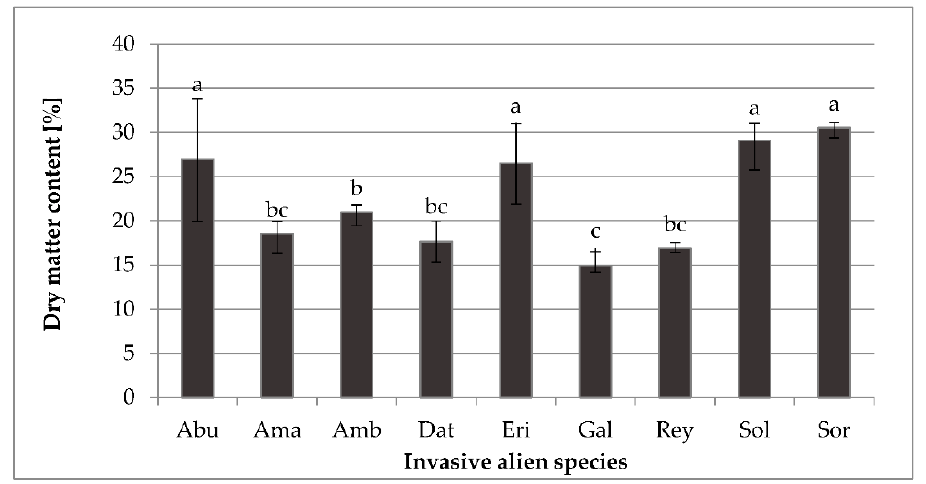
Figure 1. Dry matter content (%) of nine different invasive alien species. Abu— Abutilon theophrasti ; Ama— Amaranthus retroflexus ; Amb— Ambrosia artemisiifolia ; Dat— Datura stramonium ; Eri— Erigeron annuus ; Gal— Galinsoga ciliata ; Rey— Reynoutria japonica ; Sol— Solidago gigantea ; Sor— Sorghum halepense . Different letters (a–c) indicate significant differences between means at p ≤ 0.0001.